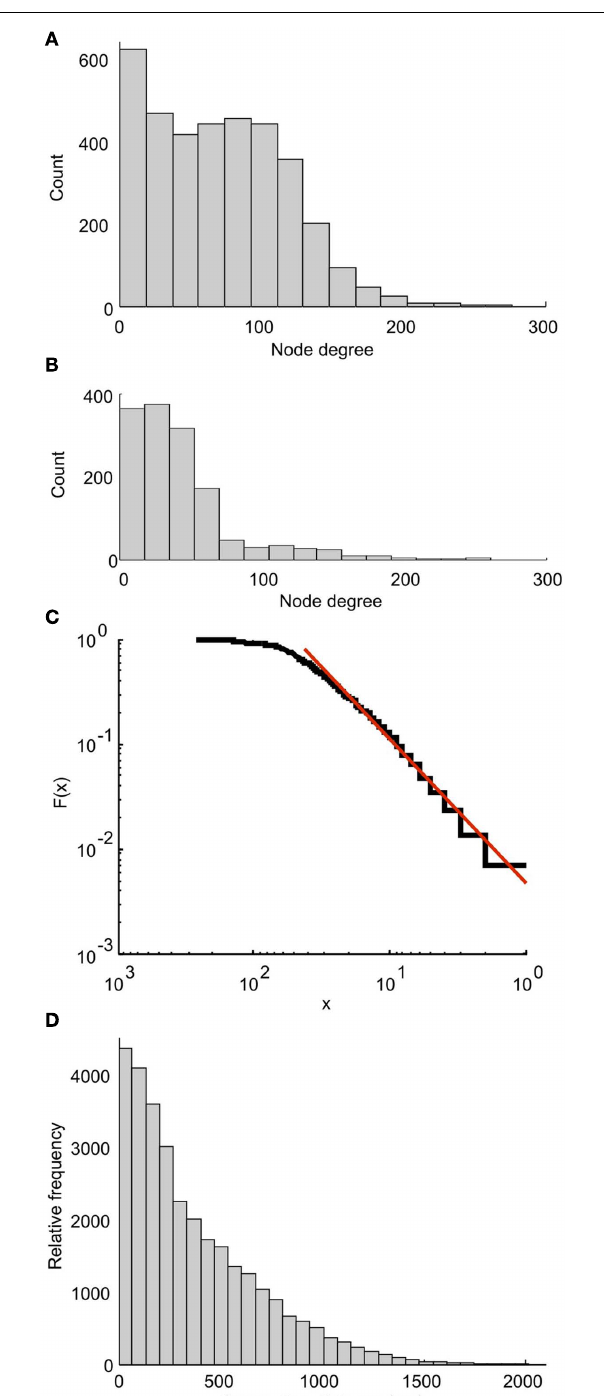
FIGURE 9 | Properties of the connectome. Node degree distributions for the whole connectome (A) and one side of the connectome (B) show that only the network on one side shows a distribution similar to the power law, and is therefore scale-free. (C) The cumulative function from (B) (blue) and a linear approximation (red) plotted on a log scale. (D) The overall distribution of connection distances for synapses between neurons on a single side of the tadpole